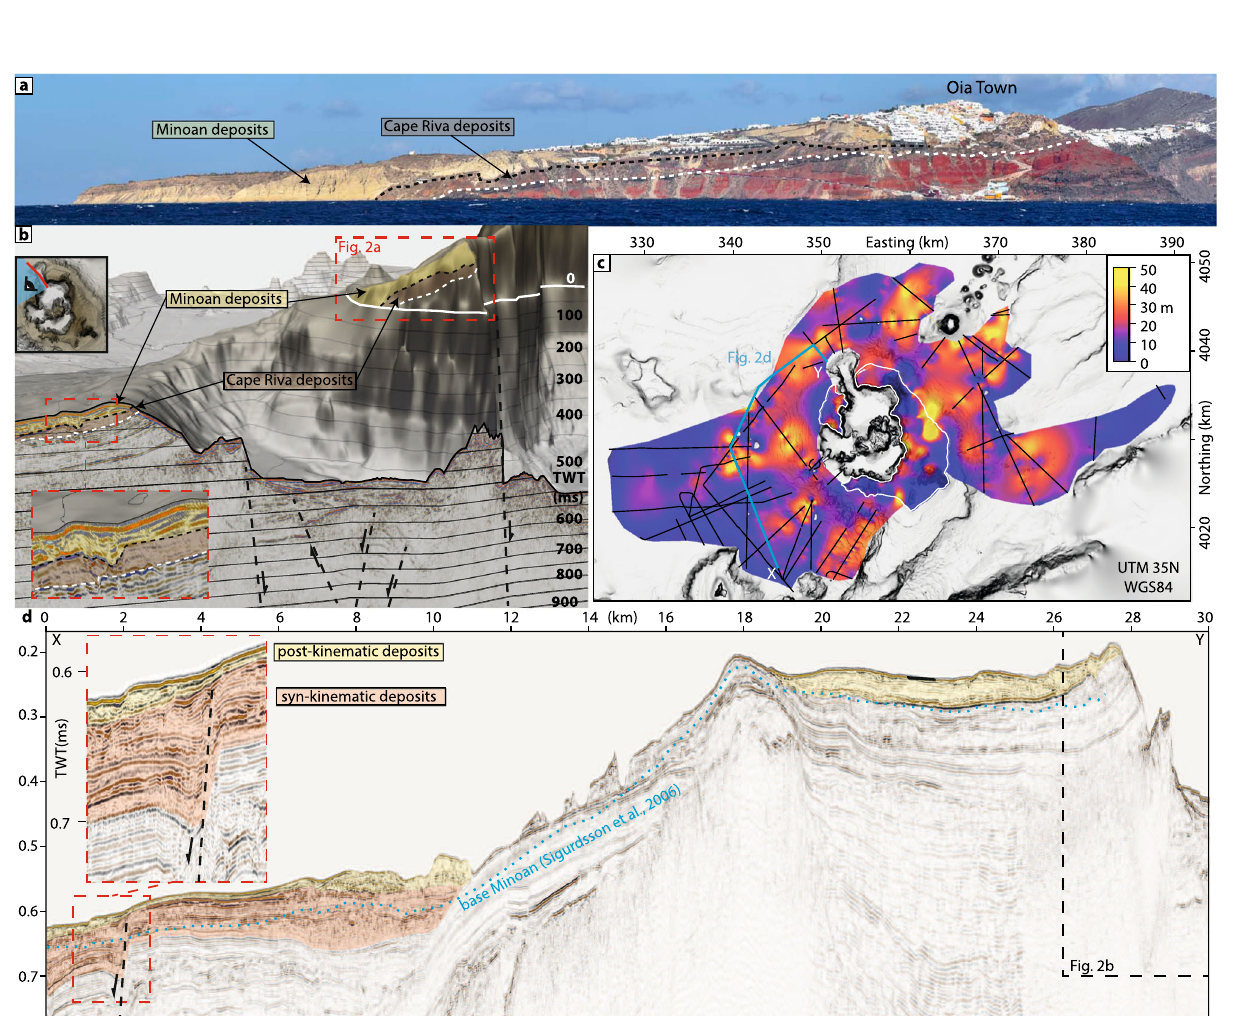
thickness from seismic mapping combined with onshore deposit mapping 3 . The white line indicates the Santorini coastline. d Seismic pro fi le showing the seismic stratigraphy northwest of Santorini. Enlargement shows the Christiana Fault with undeformed, post-kinematic (yellow) deposits interpreted as originating from the Minoaneruption, and offset, syn-kinematic sediments (orange) interpreted aspre- Minoan.